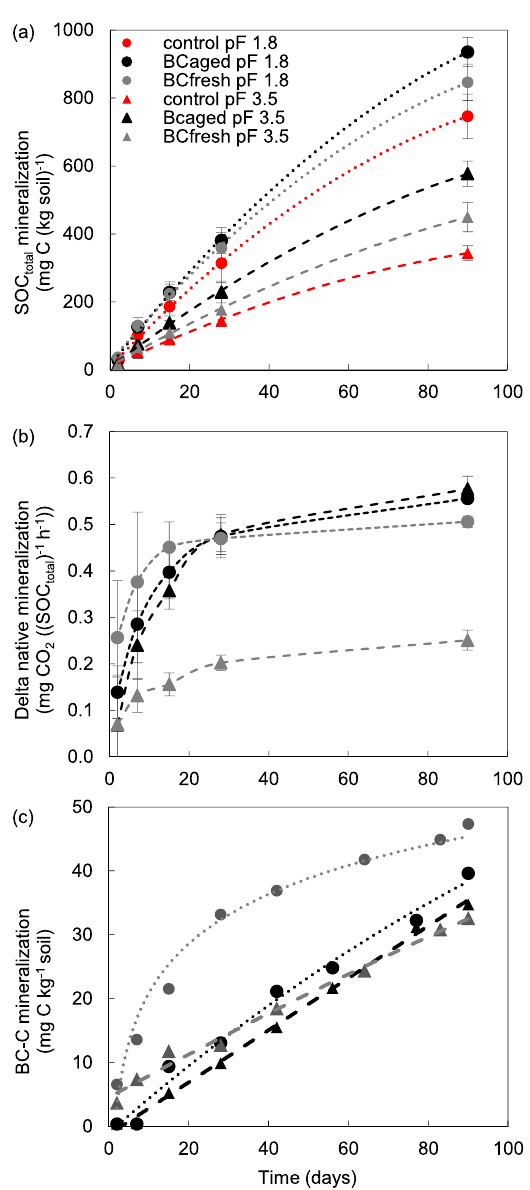
Figure 3. ( a – c ) ( a ) Cumulative CO 2 emissions, ( b ) additional native mineralization (mg per kg SOC) in BC amended soil and ( c ) cumulative BC-C mineralization (mg per kg) during 90 days of the experiment. The vertical bars represent the standard deviation (n =